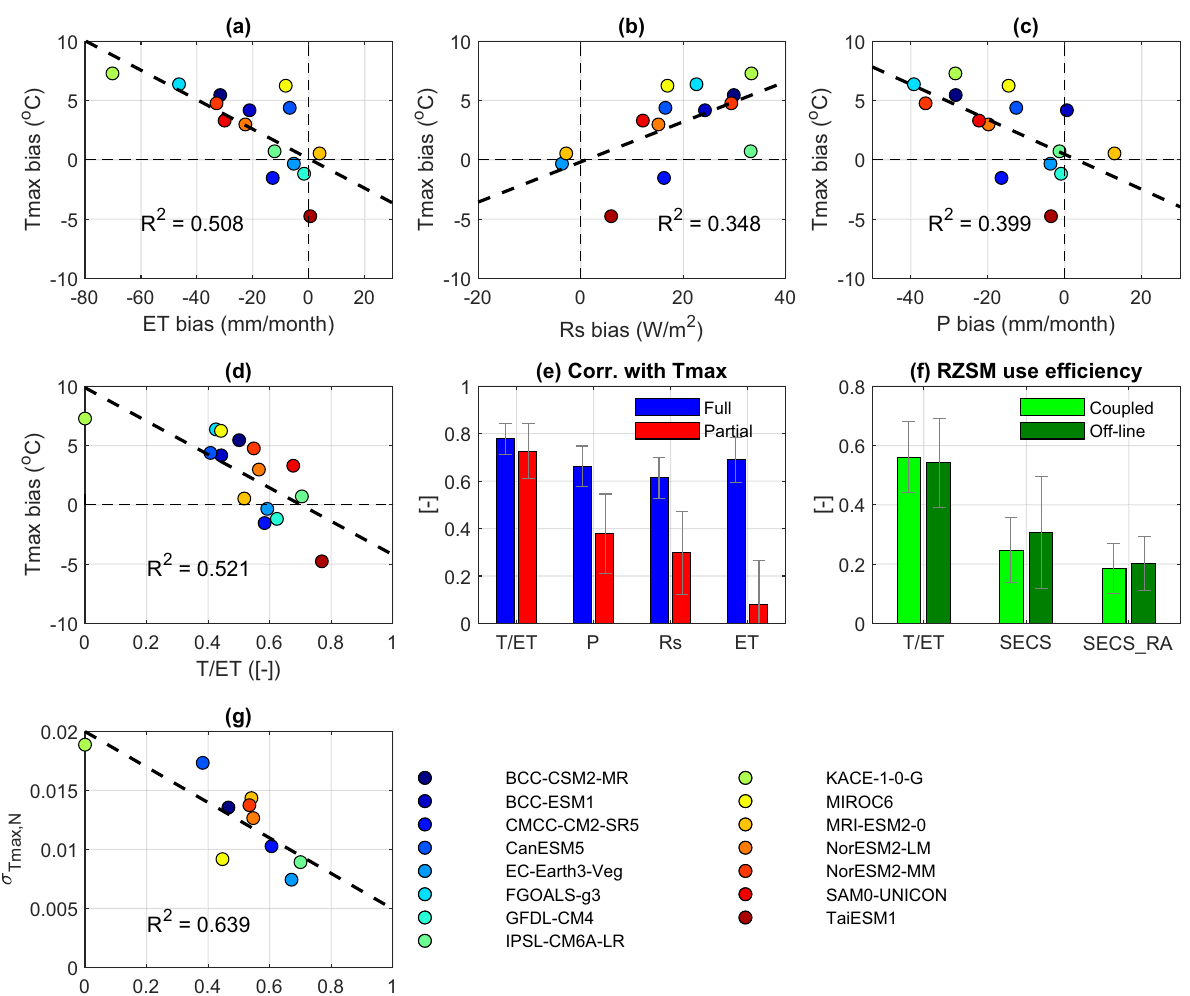
Fig. 3 Analysis of inter-model CMIP6 variability. Inter-model variability of spatially averaged 2000 – 2014 June-July-August (JJA) 2-m summertime daily maximum temperature (Tmax) biases as a function of: evapotranspiration (ET, a ), net shortwave radiation (Rs, b ), precipitation (P, c ) biases and modeled transpiration to ET ratio, (T/ET, d ) within the CUS (central contiguous United States, see Fig. 1 for geolocations). e The full-rank correlation and partial-rank correlation of Tmax bias with T/ET, P, Rs and ET biases, where error bars represent the standard deviation of a 1500-member bootstrapping analysis. f The spatial-temporal mean of CUS T/ET and SECS (soil moisture — ET coupling strength) values from three CMIP6 Earth System Models (EC-Earth3-Veg, IPSL_CM6A-LR and MIROC6) and four reanalysis systems based on coupled and off-line modeling. Error bars in (f) capture the inter-model range of variables for each model group. g Normalized high-emission scenario (SSP585) projected 2020 – 2050 detrended JJA monthly Tmax standard deviations (see Methods) as a function of JJA